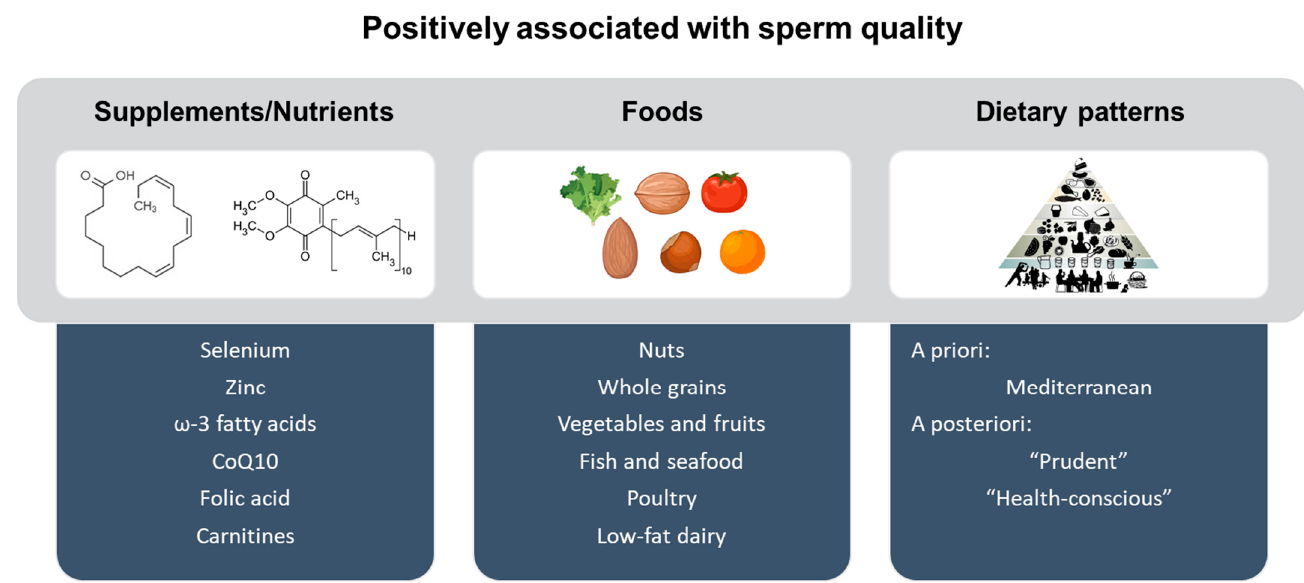
Figure 3. Supplement/nutrient intake, food consumption, and dietary pattern adherence positively associated with sperm quality parameters [61].